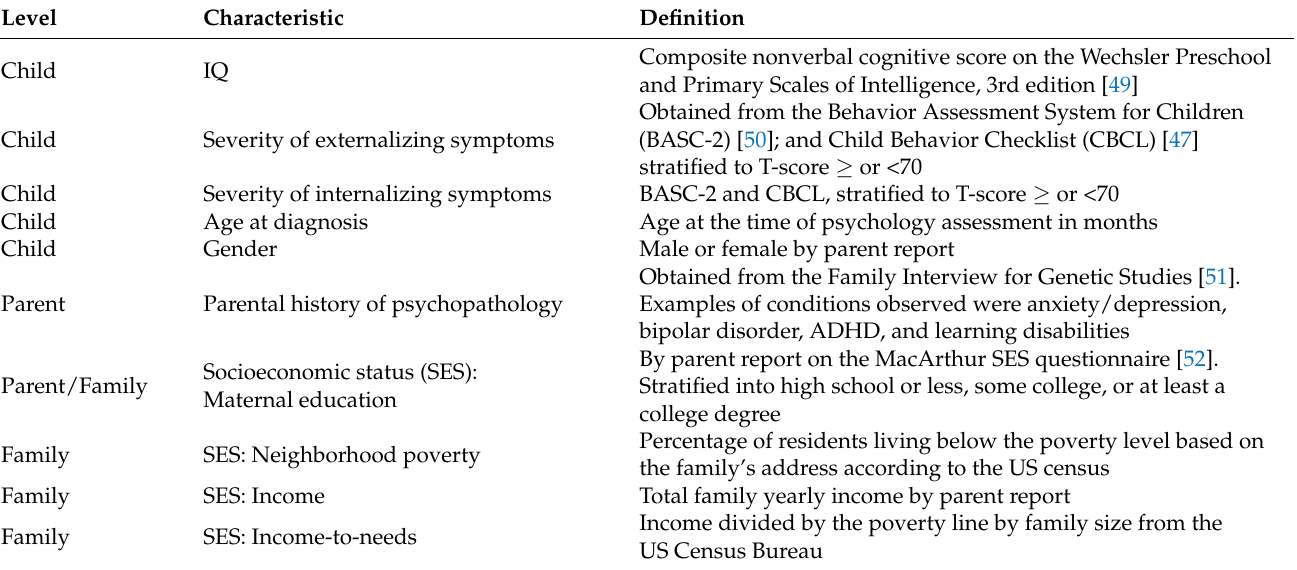
Table 1. Child, Parent, and Family